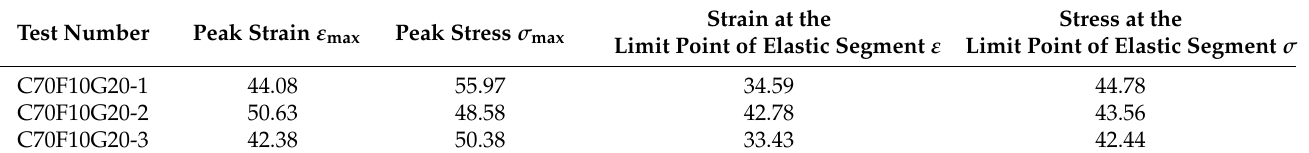
Table 9. Axial compressive strength and elastic modulus of concrete.